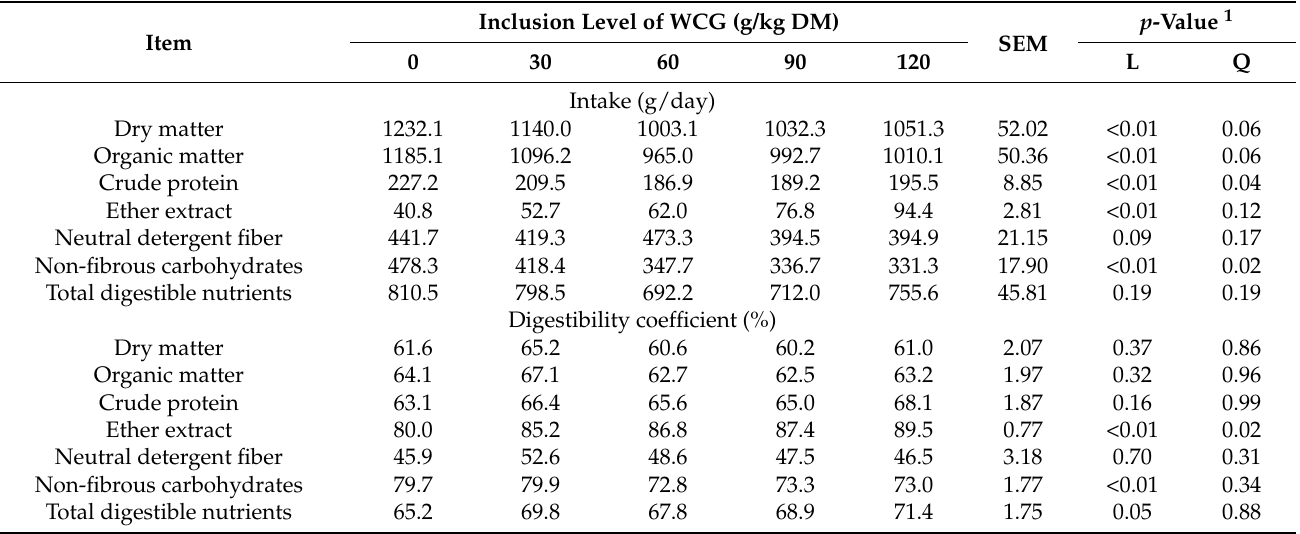
Table 1. Intake and digestibility coefficients of nutritional components in lambs fed diets containing whole corn germ.